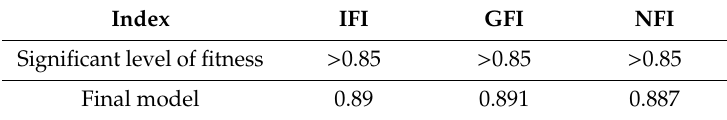
Table 4. Designed fitness indexes in the proposed model in AMOS software.